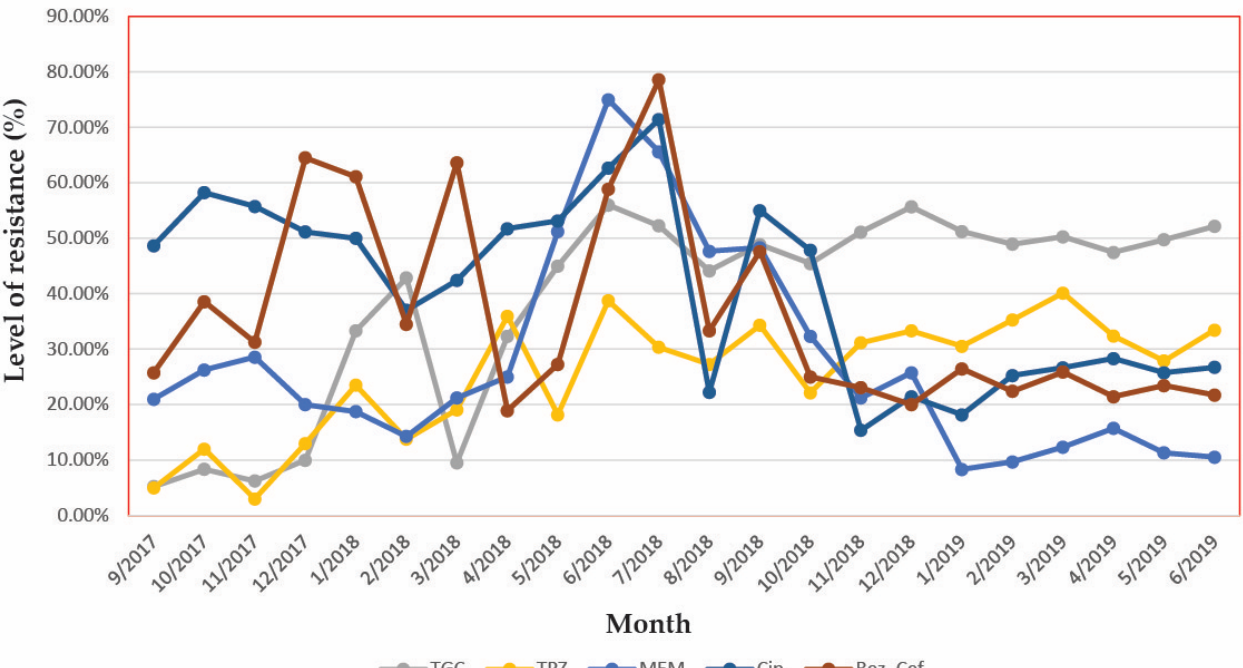
Figure 5. Evolution of antibiotic resistance in Klebsiella strains. MAR = Multiple Antibiotic Resistance index. Note: here were presented the resistance for typical antibiotics from each chemical class, however, because multiple cephalosporins were used we calculated MAR index specific for cephalosporins. TGC: Tigecyclin; TPZ: Piperacillin/Tazobactam; MEM: Meropenem; CIP: Ciprofloxacin; Rez_Cef: Resistance index to cephalosporins. Table 2. Correlations between monthly ciprofloxacin resistance of Staphylococcus aureus, E. coli, Klebsiella and